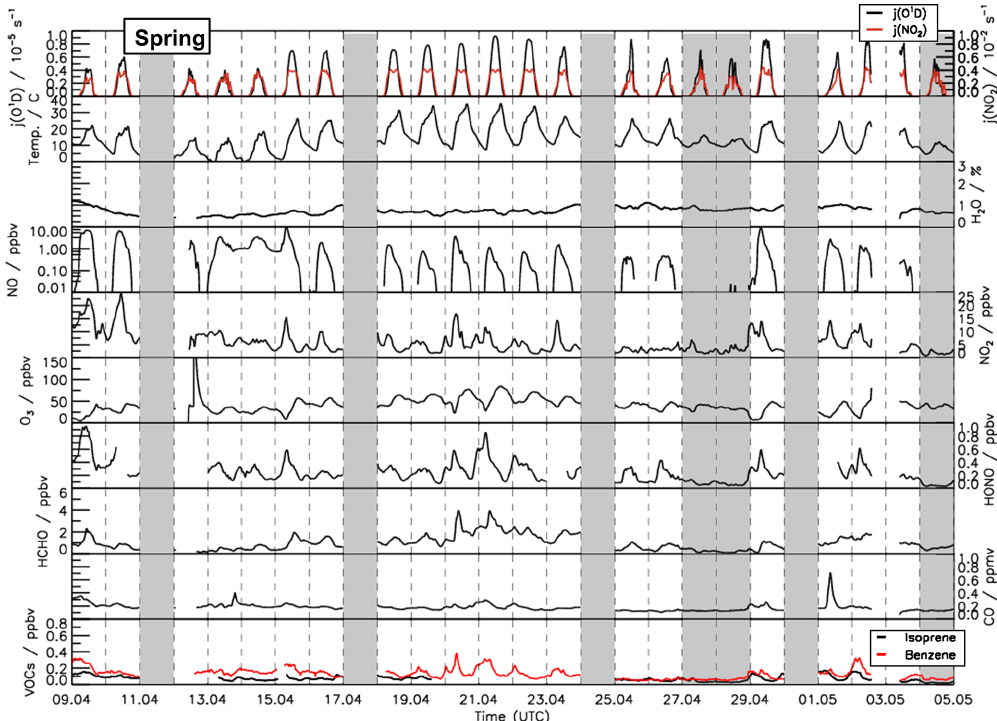
Figure 1. Time series of temperature and trace gas concentrations during the spring period of the JULIAC campaign. Vertical dashed lines denote midnight. Grey shaded areas indicate calibration days when no measurements were done and days when the chamber roof was closed due to bad weather